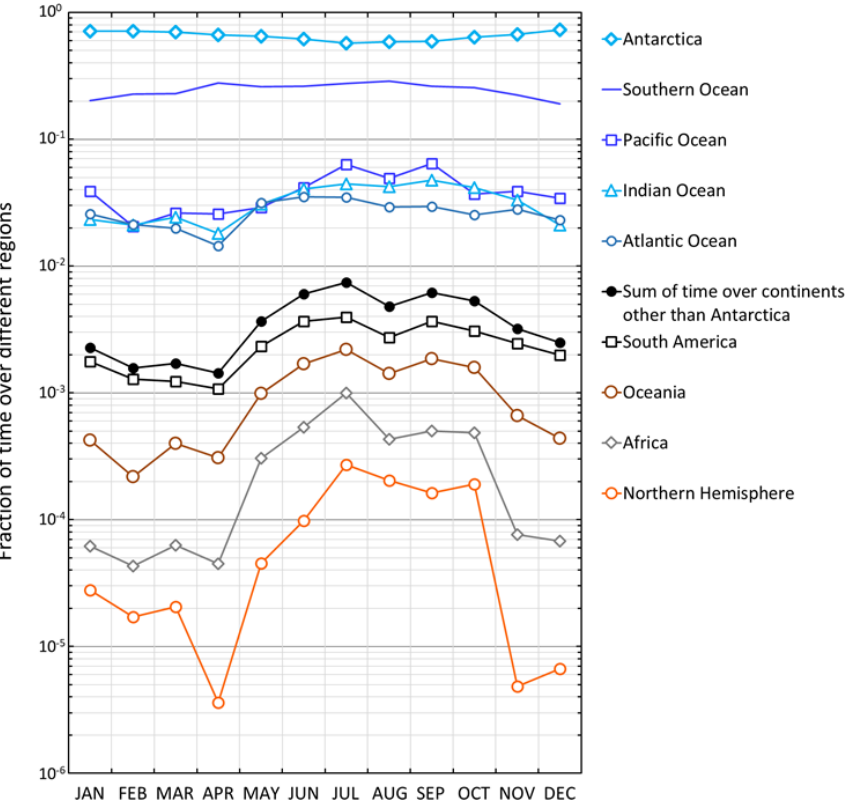
Figure 15. Seasonal air-mass transport by region calculated as the fraction of time the FLEXPART 50d trajectories spent over Antarctica and the surrounding oceans and